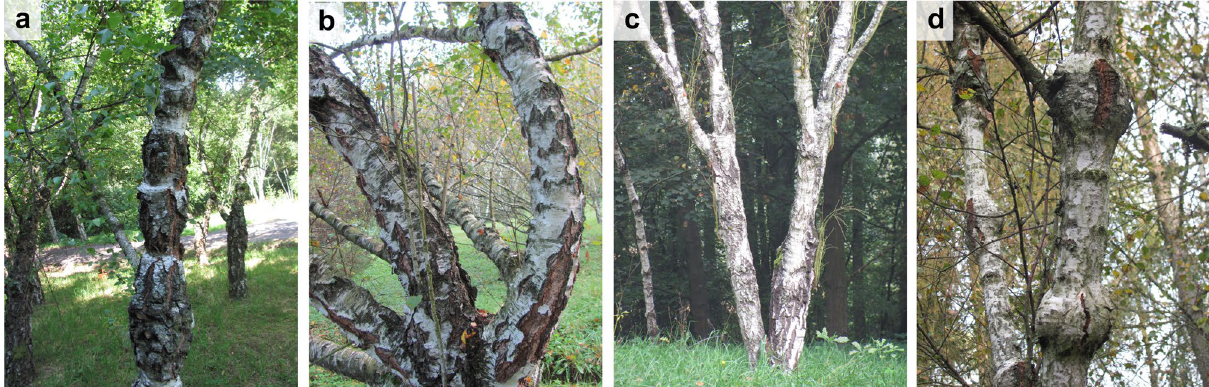
Figure 2. Appearance of curly birch in seed orchard ʻ Šíriny ʼ . The shape of bulges corresponding to four defined types: ( a ) ring, ( b ) dense, ( c ) shallow, ( d ) sphere (photo by I.